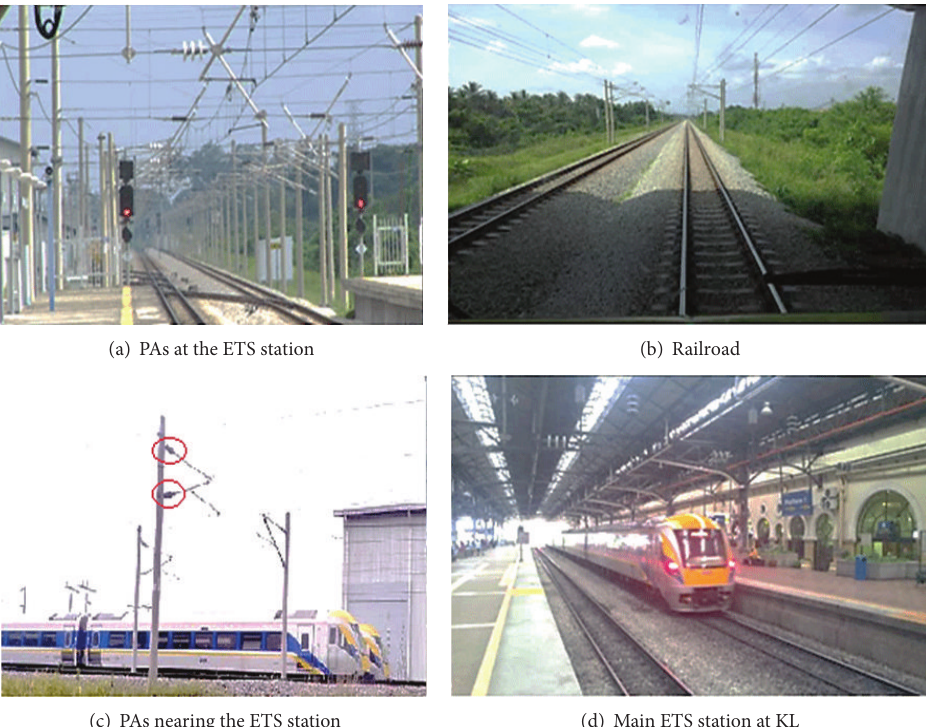
Figure 2: Obstacles in Malaysia high speed train